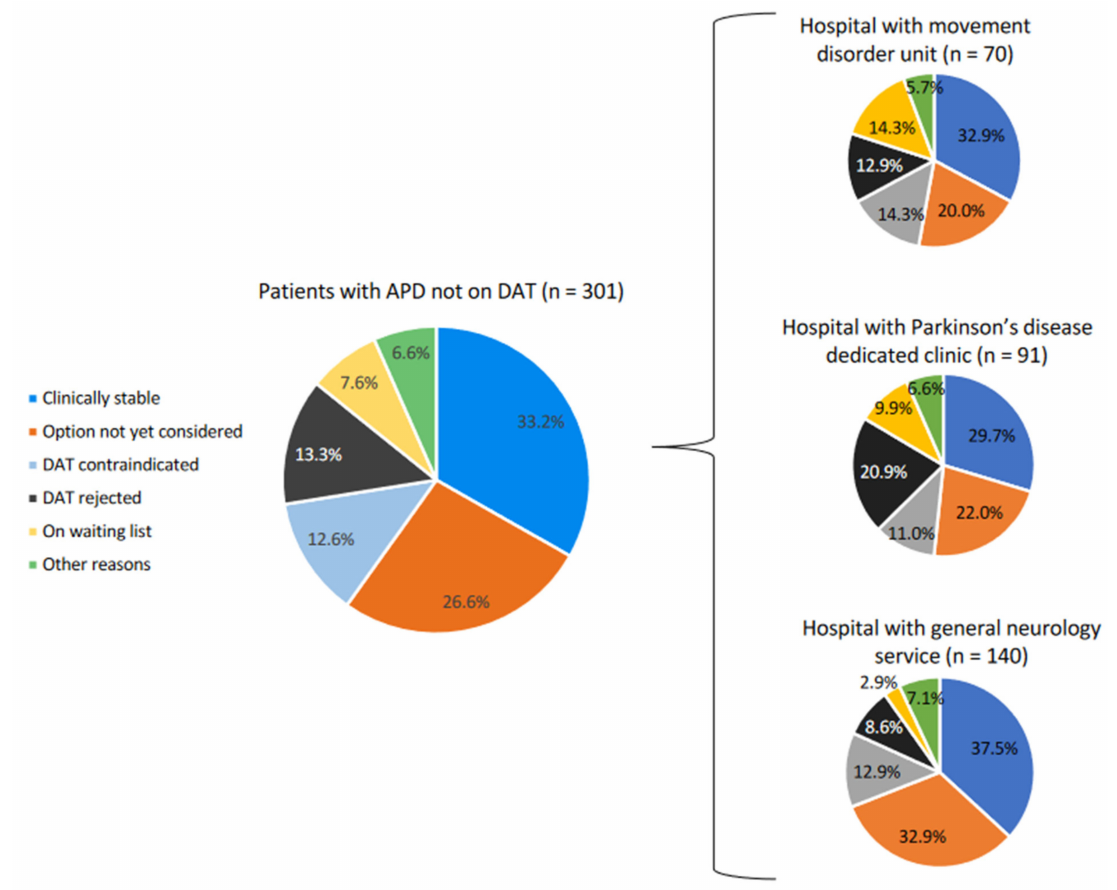
Figure 1. Reasons why patients with ADP were not on a DAT. ADP, advanced Parkinson’s disease; DAT, device-aided therapy. Statistically significant differences among hospital types ( p = 0.028).